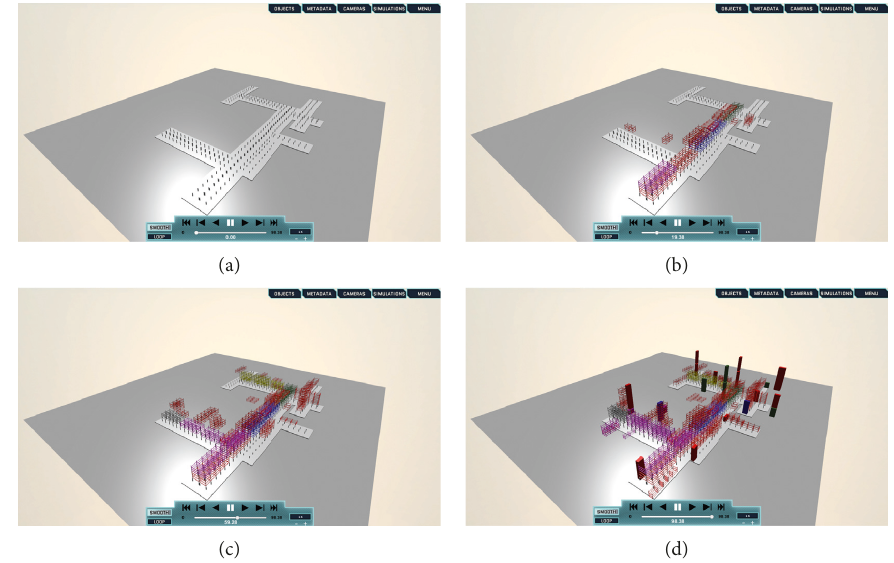
Figure 8: A sequence of screenshots that shows module installation in an oil and gas